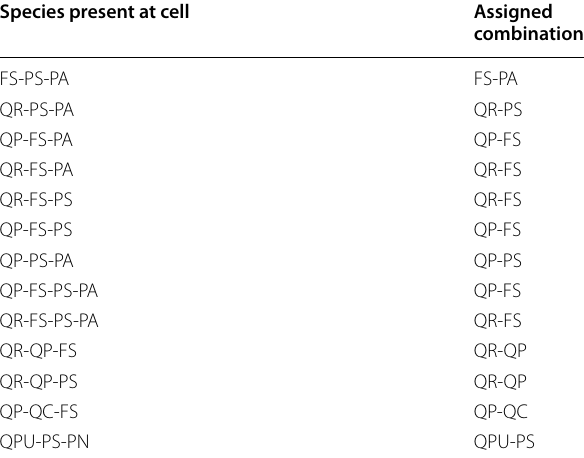
Table 6 Simplification scheme of grid points containing combinations of at least three tree species Species present at cell Assigned